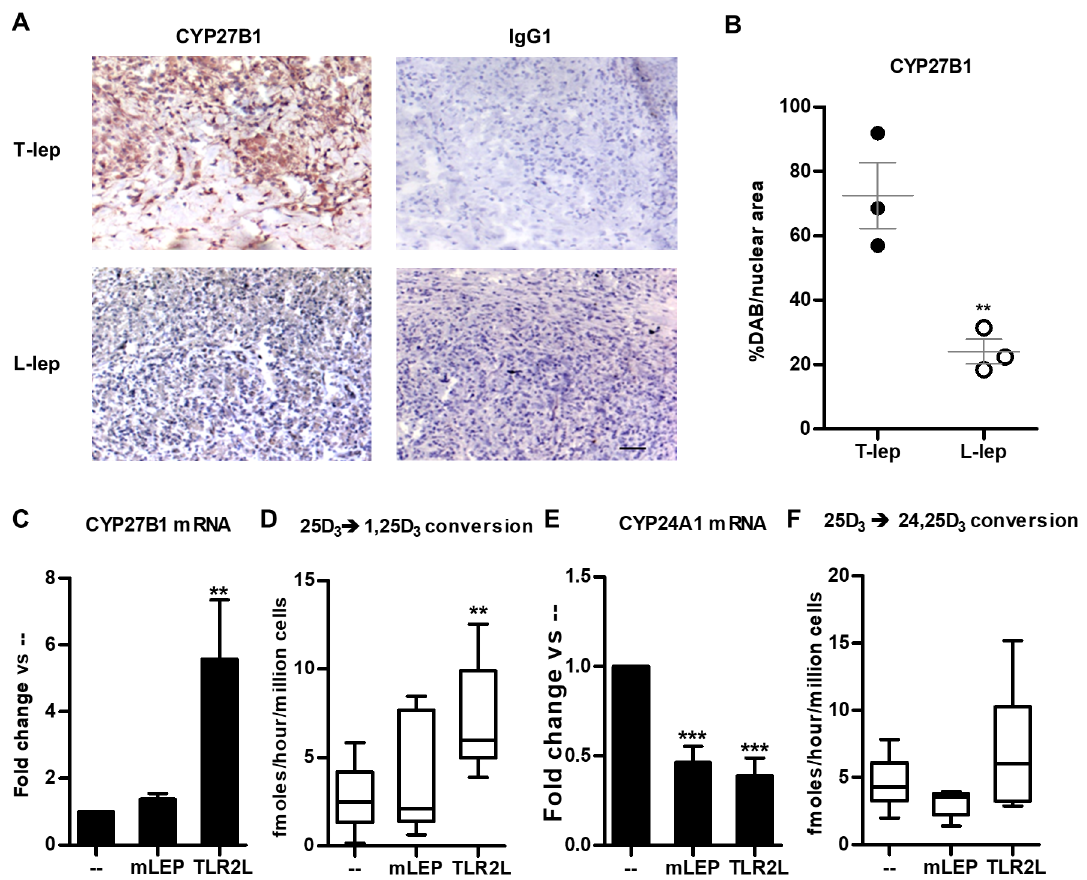
Fig 1. CYP27B1 expression in leprosy and during M . leprae infection of primary human monocytes. ( A ) One representative labeled section displaying CYP27b1 protein detection in leprosy lesions from one patient, (patient, n = 3), scale bar = 40 μ m. Original magnification: x100. ( B ) Automated image analysis of CYP27b1 protein expression. Each dot represents the percentage of CYP27b1– stained area per nuclear area for each individual photomicrograph (n = 3 for each group). Data represent mean ± SEM. Statistical significance was determined using student t-test. Primary human monocytes were treated with M . leprae at a multiplicity of infection (MOI) of 10 or 100ng/mL Pam 3 CSK 4 (TLR2L) for 24 hours and ( C ) CYP27B1 and gene expression levels were determined by quantitative PCR, or the cells were incubated with radiolabeled 25D 3 for 5 hours, and (D) conversion to 1,25D 3 was measured by high performance liquid chromatography (HPLC). Gene expression of ( E ) CYP24A1 and ( F ) conversion of 25D 3 into 24,25D 3 were also measured. Data are shown as mean ± SEM, n > 3. Statistical significance was determined using one-way ANOVA. ( (cid:3) p (cid:20) 0.05, (cid:3)(cid:3) p (cid:20) 0.01, (cid:3)(cid:3)(cid:3) p (cid:20) 0.001).